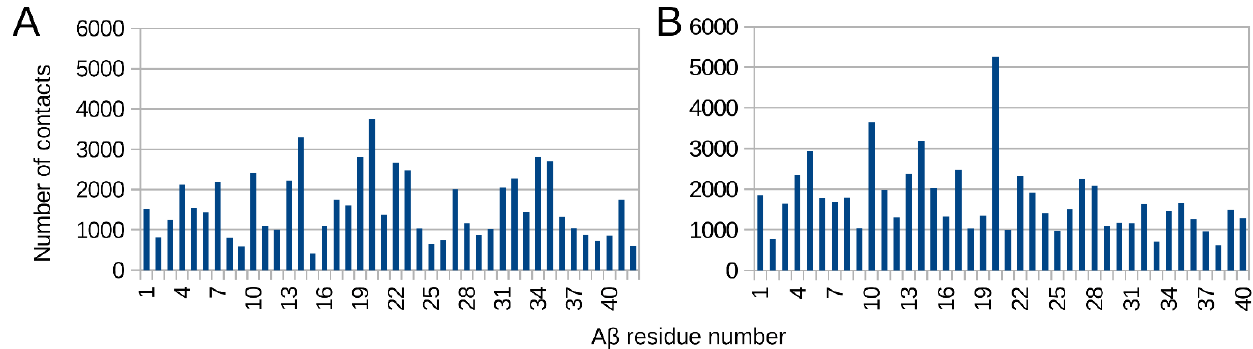
Figure 6. Contact frequency histogram for Aβ 42 ( A ) and Aβ 40 ( B ) residues over 160 complexes with RAGE. Global docking results for the Aβ 42 and the Aβ 40 to RAGE protein performed with servers LzerD, ATTRACT, PatchDock ClusPro, Hdock and Zdock and analyzed with QASDOM software. A total of 30 best complexes from each have been used for the analysis, and 10 complexes from